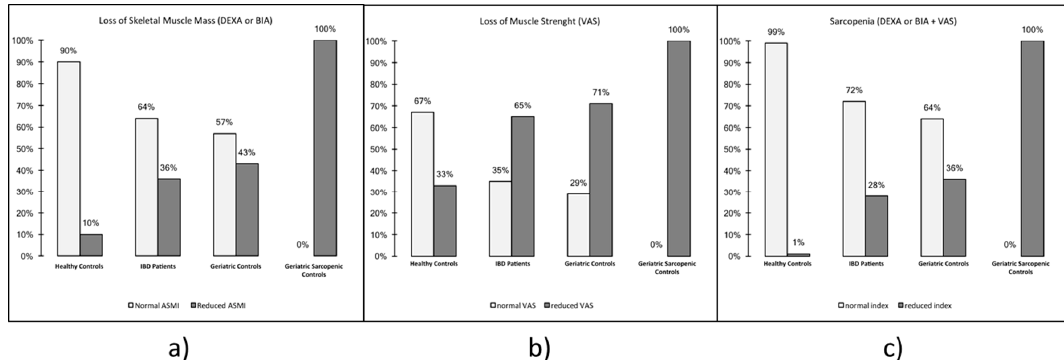
Figure 1. Percentage of sarcopenia in the study population: IBD patients, healthy controls, geriatric controls and geriatric sarcopenic controls. ( a ) Loss of skeletal muscle mass, ( b ) loss of muscle strength, and ( c ) loss of skeletal muscle mass and muscle strength: sarcopenia. Abbreviations. IBD: Inflammatory Bowel Disease; DEXA: Dual Energy X-ray Absorptiometry; BIA: Bio-Impedensometric Analysis. VAS: Visual Analogue Scales. ASMI: Appendicular Skeletal Mass Index Table 2. Biometric evaluation: parameters by measurement device.